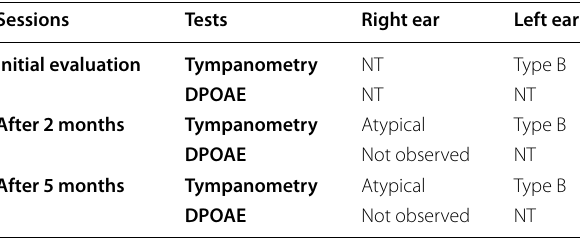
Table 1 The results of the evaluation of the tympanometry and otoacoustic emission